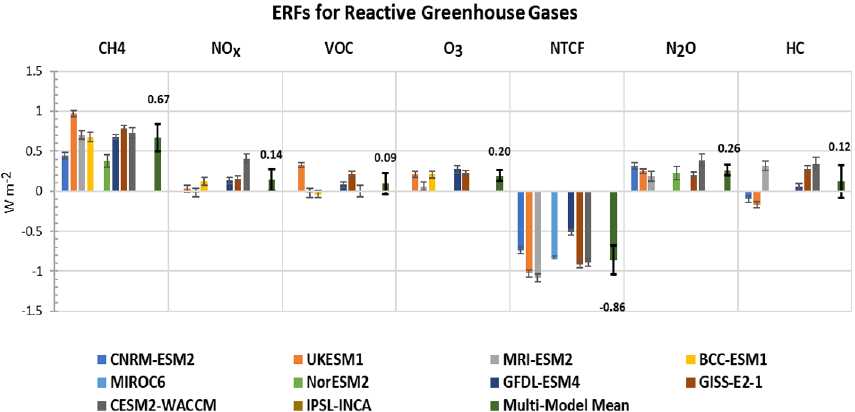
Figure 5. Reactive gas ERFs for the models with the available diagnostics for the reactive gas experiments with interannual variability represented by error bars showing the standard error. The multi-model mean is shown with the mean value and error bars indicating the standard